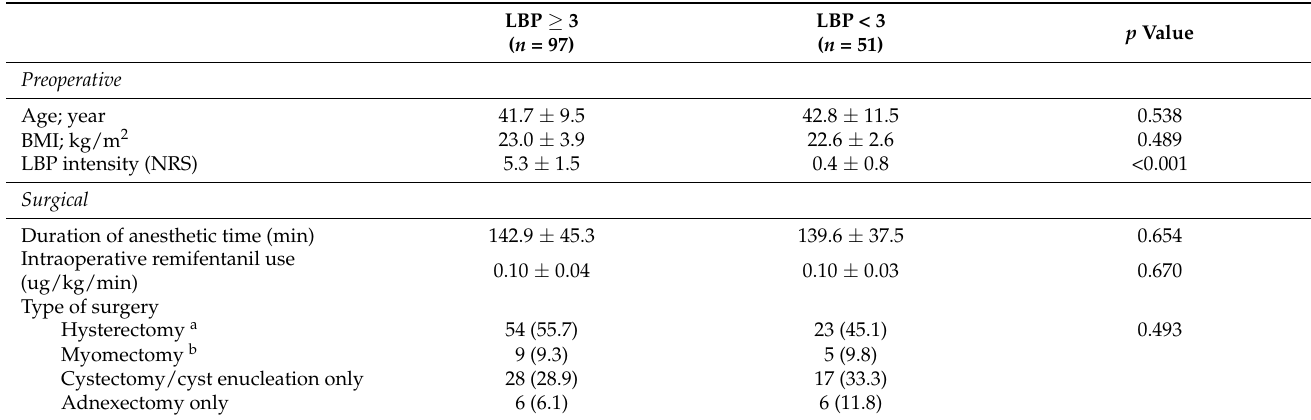
Table 2. Demographic and surgical data in patients dichotomized for preoperative lower back pain intensity. Values are as means ± SD or number